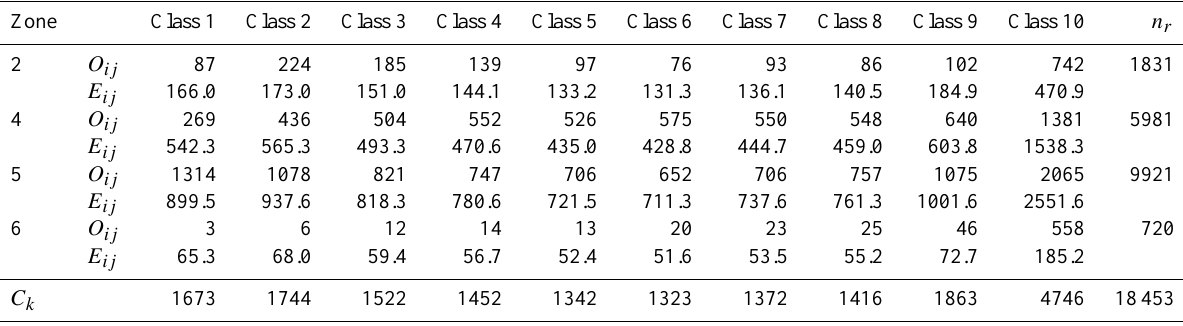
Table 9. Summary of results obtained in the chi-square test of time